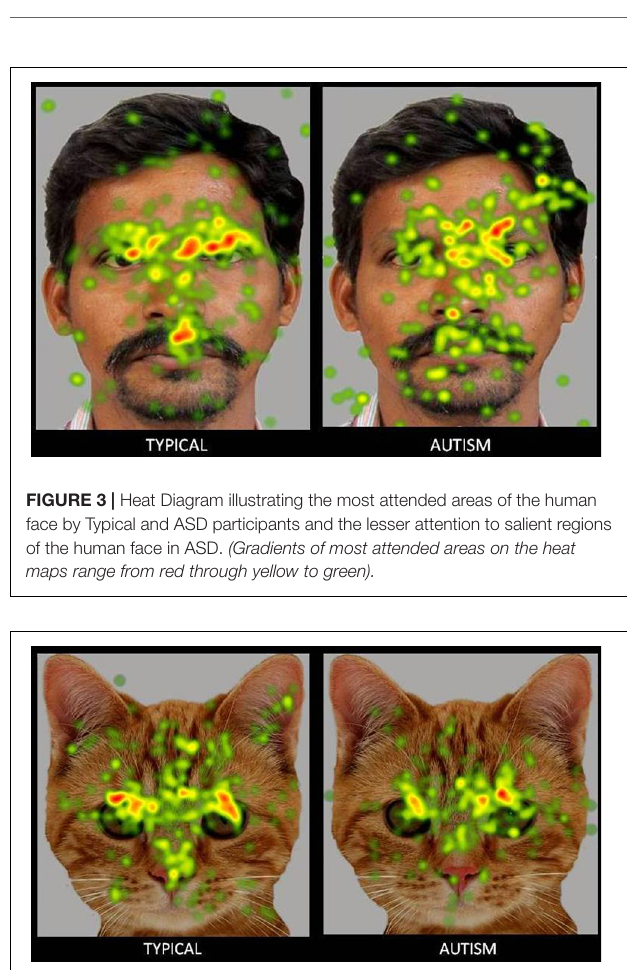
FIGURE 4 | Heat Diagram illustrating the most attended areas of the animal face by Typical and ASD participants and the lesser attention to salient regions of the animal face in ASD. Gradients of most attended areas on the heat maps range from red through yellow to green).